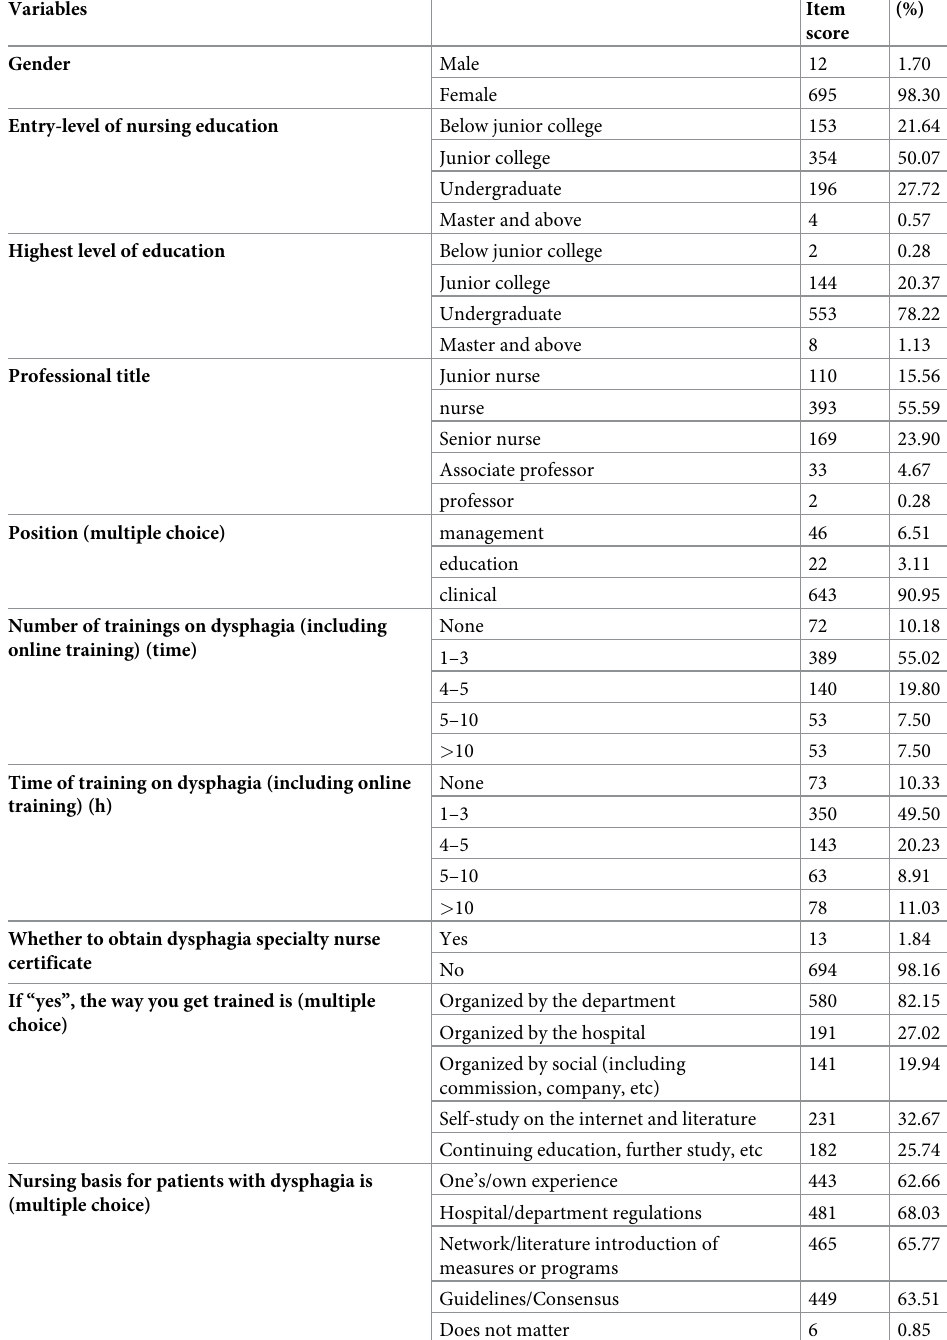
Table 1. General characteristics of participants (n =